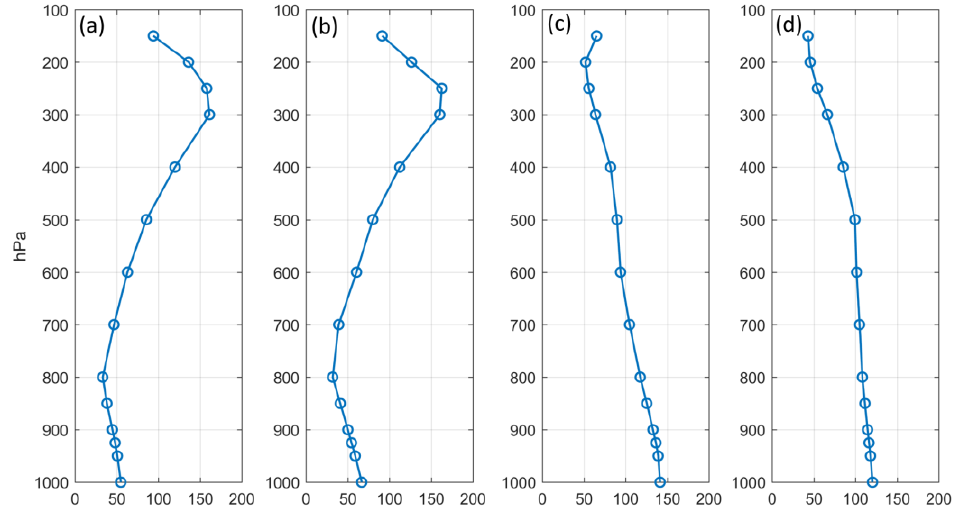
Figure 4. Temporal variation of the vertical profile of 𝛥𝛧 (i.e., the difference between maximum and minimum value of geopotential height at a specific isobaric level within the employed circle with a radius of 200 km) at ( a ) 27/06 UTC, ( b ) 27/12 UTC, ( c ) 28/06 UTC, and ( d ) 28/12 UTC.